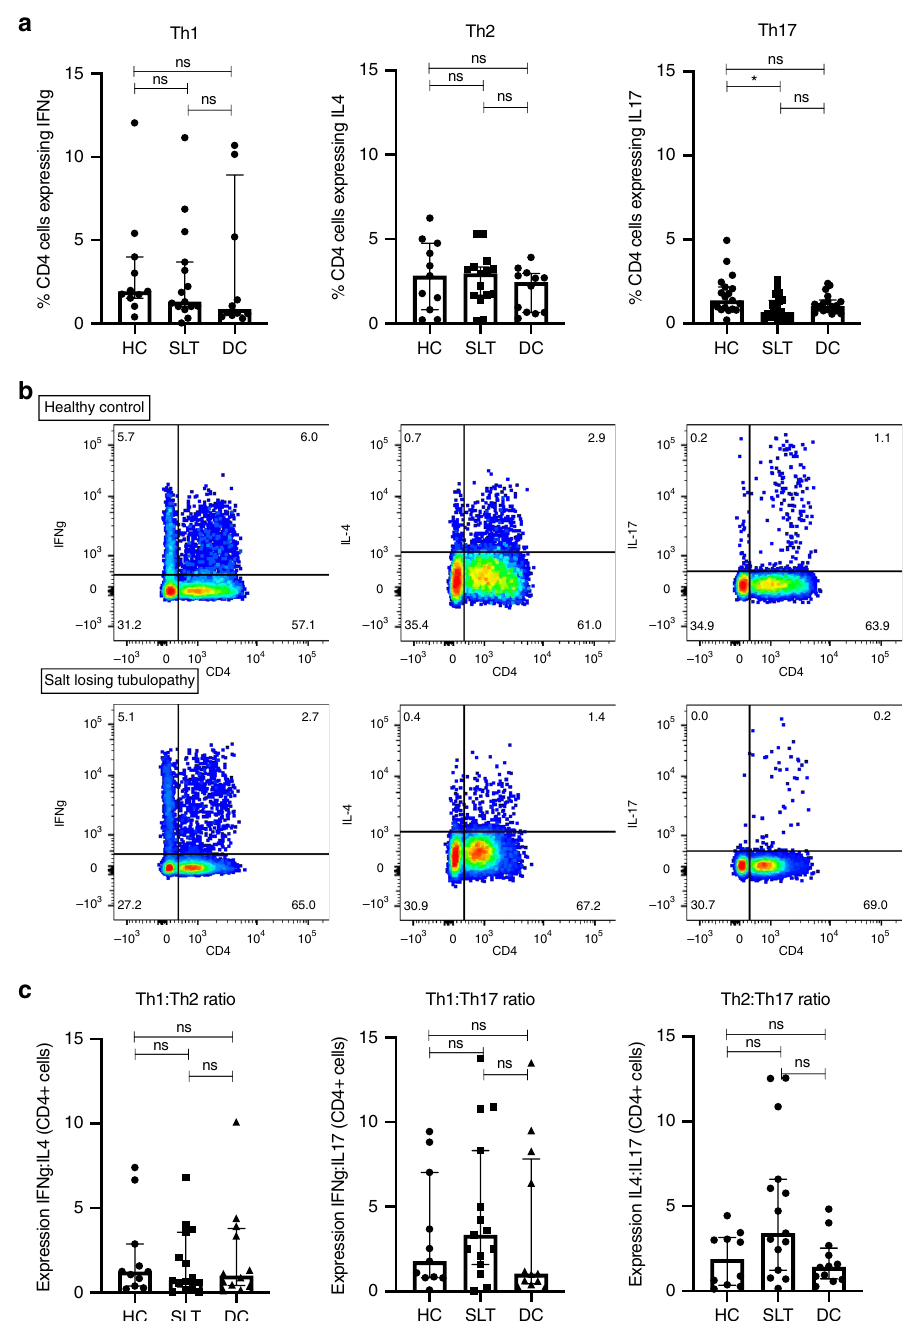
Fig. 3 CD4 subset analysis in salt-losing tubulopathy patients and controls. a IFN γ , IL-4, and IL-17 expression in CD4 + cells after 4 h stimulation with phorbol myristate acetate and ionomycin in SLT patients ( n = 15), healthy controls ( n = 11), and disease controls ( n = 12). Cytokine expression is reported as percentage of CD4 + cells. Groups are compared with a Kruskal – Wallis test with Dunn ’ s multiple comparison testing (shown with signi fi cance bars). Error bars represent interquartile range around the median. IFN γ expression: HC 1.9% (1.5 – 4.0), SLT 1.3% (1.0 – 3.7), DC 0.9% (0.5 – 8.9), p = 0.53. IL-4 expression: HC 2.8% (0.8 – 4.8), SLT 3.0% (1.7 – 3.3), DC 2.5% (0.7 – 3.0), p = 0.52. IL-17 expression: HC 1.4% (0.9 – 2.2), SLT 0.7% (0.3 – 1.4), DC 1.0% (0.8 – 1.4), p = 0.038. b Representative FACS dot plots of IFN γ , IL-4, and IL-17 expression in CD4 + cells in a SLT patient and HC. Cell proportions as percentages are documented within each quadrant. c Ratio of IFN γ , IL-4, and IL-17 expression in each subject in SLT patients ( n = 15), HC ( n = 11), and DC ( n = 12). Groups are compared with a Kruskal – Wallis test with Dunn ’ s multiple comparison testing (shown with signi fi cance bars). Error bars represent interquartile range around the median. IFN γ :IL-4 (Th1:Th2): HC 1.2 (0.4 – 2.9), SLT 0.7 (0.3 – 3.9), DC (1.0 (0.4 – 3.9), p = 0.82). IFN γ :IL-17 (Th1:Th17): HC 1.8 (0.8 – 7.0), SLT 3.3 (1.6 – 8.3), DC 1.0 (0.5 – 7.8), p = 0.40. IL-4:IL-17 (Th2:Th17): HC 1.9 (0.4 – 3.2), SLT 3.4 (1.2 – 6.6), DC 1.4 (0.7 – 2.5), p = 0.05. ns not signi fi cant ( p > 0.05), * p ≤ 0.05, ** p ≤ 0.01, *** p ≤ 0.001, **** p ≤ 0.0001, HC healthy control, SLT salt-losing tubulopathy, DC disease control. Source data are provided as a Source data fi